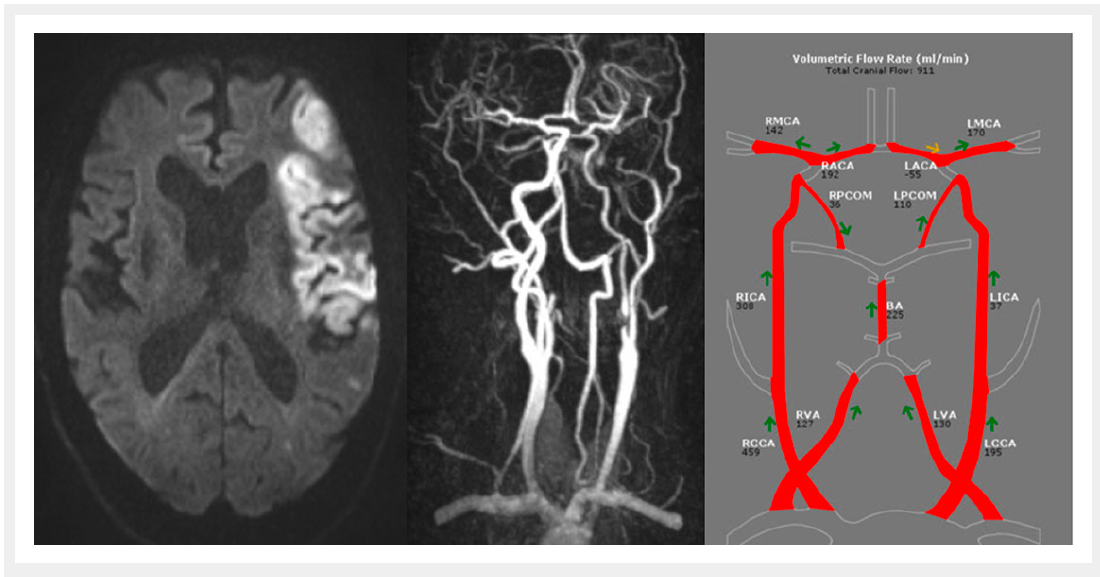
Figure 5 Illustrative case of a 61 year male patient with ischaemic stroke in the left MCA territory due to high grade stenosis of the left ICA with consecutive reversal of flow in the left ACA. BA = basilar artery; LACA = left anterior cerebral artery; LCCA = left common carotid artery; LICA = left internal carotid artery; LMCA = left middle cerebral artery; LPCA = left posterior cerebral artery; LVA = left vertebral artery; RACA = right anterior cerebral artery; RCCA = right common carotid artery; RICA = right internal carotid artery; RMCA = right middle cerebral artery; RPCA = right posterior cerebral artery; RVA = right vertebral